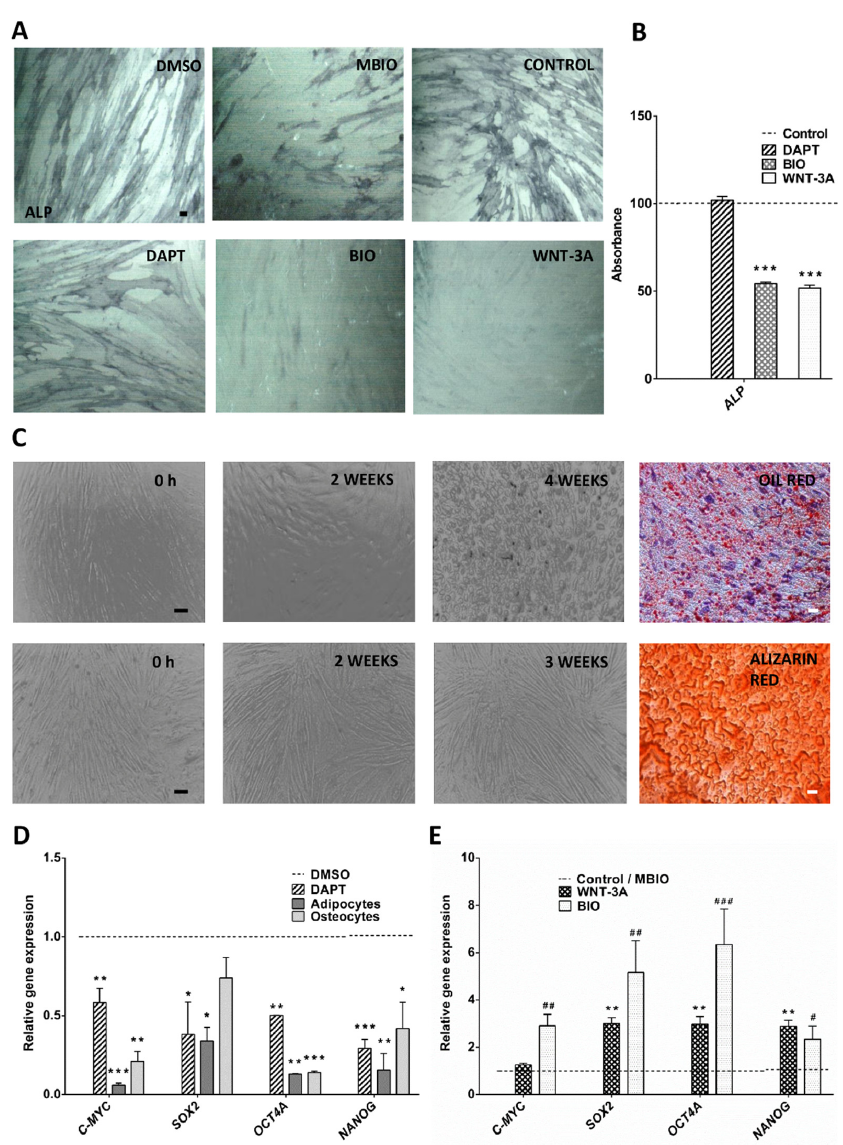
Figure 1. Notch and Wnt signaling regulate cell di ff erentiation and pluripotency core factor expression in DPSCs ( A ) : ALP activity assay showed that Wnt activation suppressed the default osteoblastic pre-commitment in DPSCs. Scale bar = 100 µ m. ( B ): Quantification of ALP absorbance in DPSC cultures after WNT-3A / BIO application ( C ): DPSC di ff erentiation to adipocytes and osteocytes. Phase-Contrast (PC) Microscopy and Alizarin S Red and Oil Red staining showed a phenotypic change and terminal di ff erentiation of control DPSCs after adipoinduction and osteoinduction treatments. Top panel: terminal adipocyte di ff erentiation was assessed by Oil Red (bright red spots) staining after 4 weeks, cell nuclei are counterstained with Hematoxylin; bottom panel: terminal osteoblastic di ff erentiation was assessed by Alizarin Red staining after 3 weeks. Scale bar = 100 µ m (Alizarin, Oil Red). Scale bar = 20 µ m (PC) ( D ): Q-PCR transcript expression analysis for core pluripotency factors C-MYC, SOX2, OCT4A and NANOG between control and terminally di ff erentiated DPSC cultures, and also between control and DAPT-treated DPSCs ( E ) : Q-PCR analysis of core factors in DPSC cultures after BIO / WNT-3A application, with respect to their respective controls MBIO / PBS (dashed line). Data are normalized to reference β -ACTIN and GAPDH levels and presented as the mean + SEM ( n = 3). *: p < 0.05; **: p < 0.01; ***: p < 0.001. Dunn’s Test, Kruskal- Wallis H Test. Asterisks (*) report significance with respect to controls PBS / DMSO, and Hash symbol (#) represents significance with respect to control MBIO. #: p < 0.05; ##: p < 0.01; ###: p <